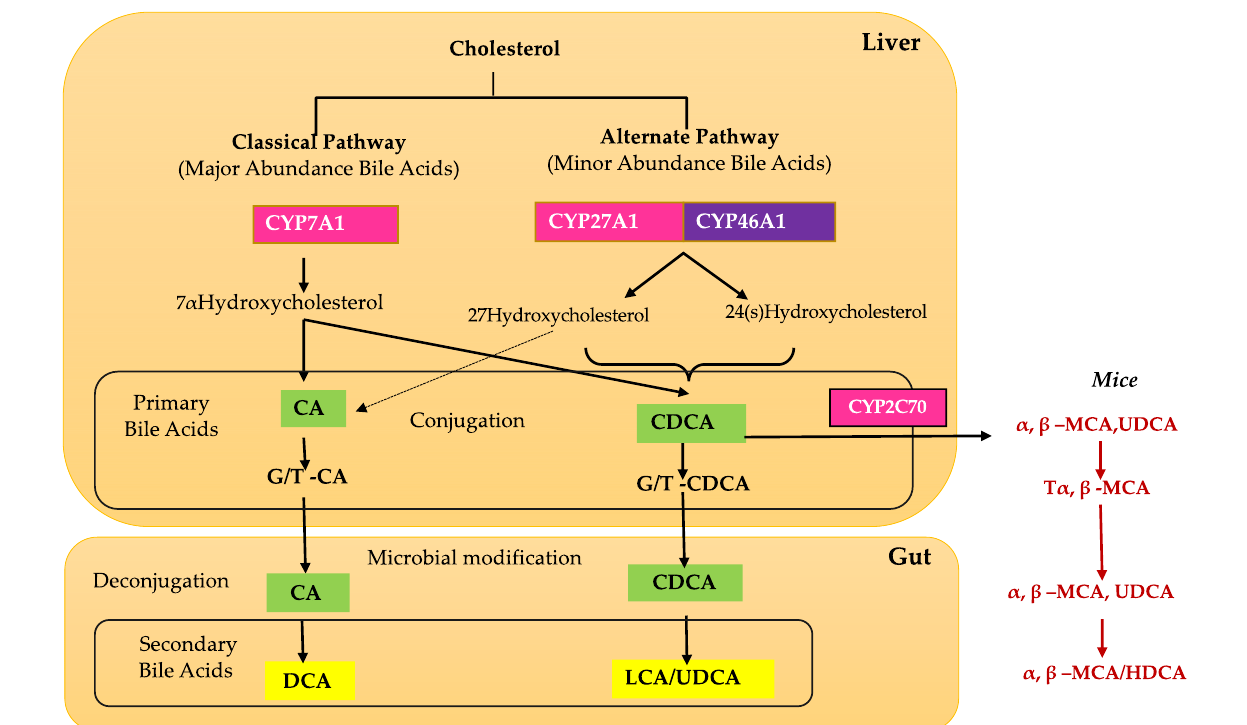
Figure 1. Overview of bile acid metabolism. Bile acids (BAs) are synthesized via two major biosynthetic pathways. In the classic pathway , cholesterol is converted to 7 α -hydroxycholesterol by the rate-limiting enzyme CYP7A1 (cholesterol 7 alpha-hydroxylase A1). 7 α -hydroxycholesterol is ultimately converted into CA (cholic acid) by a sterol 12 α -hydroxylase (CYP8B1) or CDCA (chenodeoxycholic acid) without 12 α -hydroxylation by CYP8B1. In the alternative pathway , cholesterol is first converted to 27-hydroxycholesterol by CYP27A1 (cytochrome P450 Family 27 Subfamily A Member 1), which eventually is converted to CDCA. In the large intestine, bacterial 7 α -dehydroxylase removes a hydroxyl group from C-7 and converts CA to DCA (deoxycholic acid) and CDCA to LCA (lithocholic acid). In mouse liver, most of CDCA is converted to α - and β -MCA. In the intestine, bacterial 7 α -dehydroxylase activity converts CA and CDCA to DCA and LCA, respectively. CYP3A1 (cytochrome P450 3A1) and epimerase also convert CDCA to the secondary BAs, including THCA (taurohyocholic acid), TMDCA (tauromurideoxycholic acid), ω-MCA (ω-muricholic acid), THDCA (taurohyodeoxycholic acid), and TUDCA (tauroursodeoxycholic acid). LCA and ω-MCA are excreted into feces.